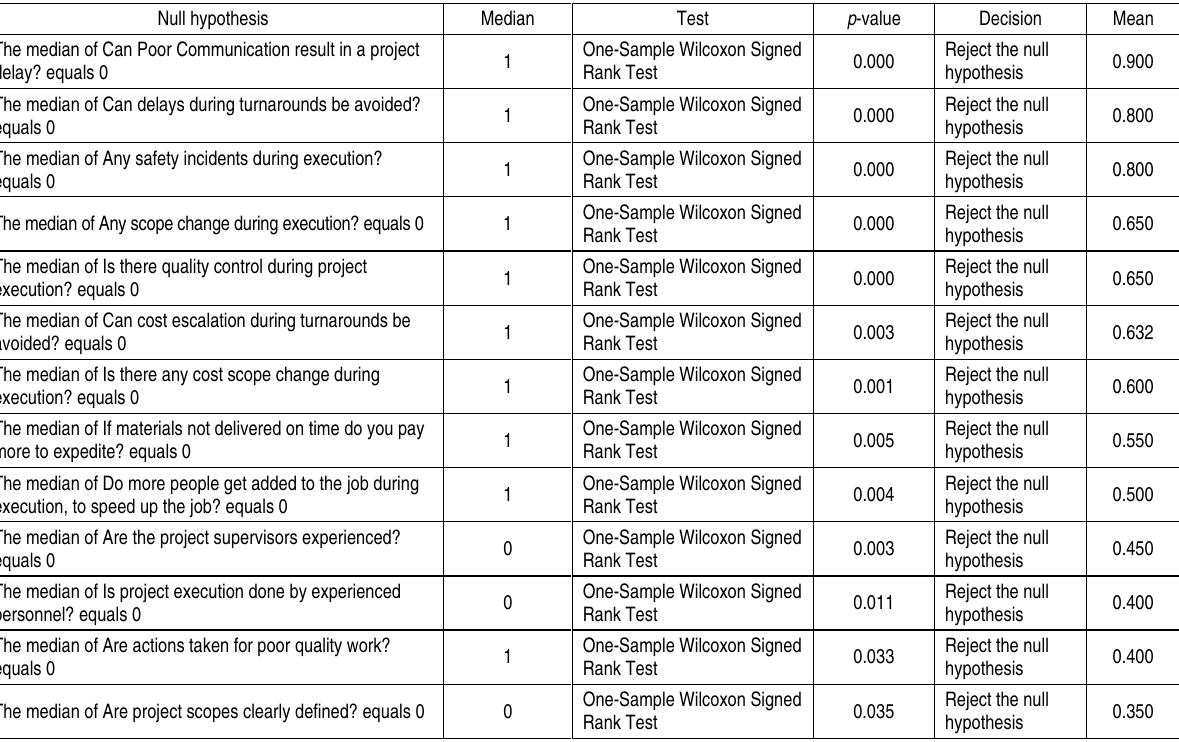
Table 3a. One-Sample Wilcoxon Signed Rank Test